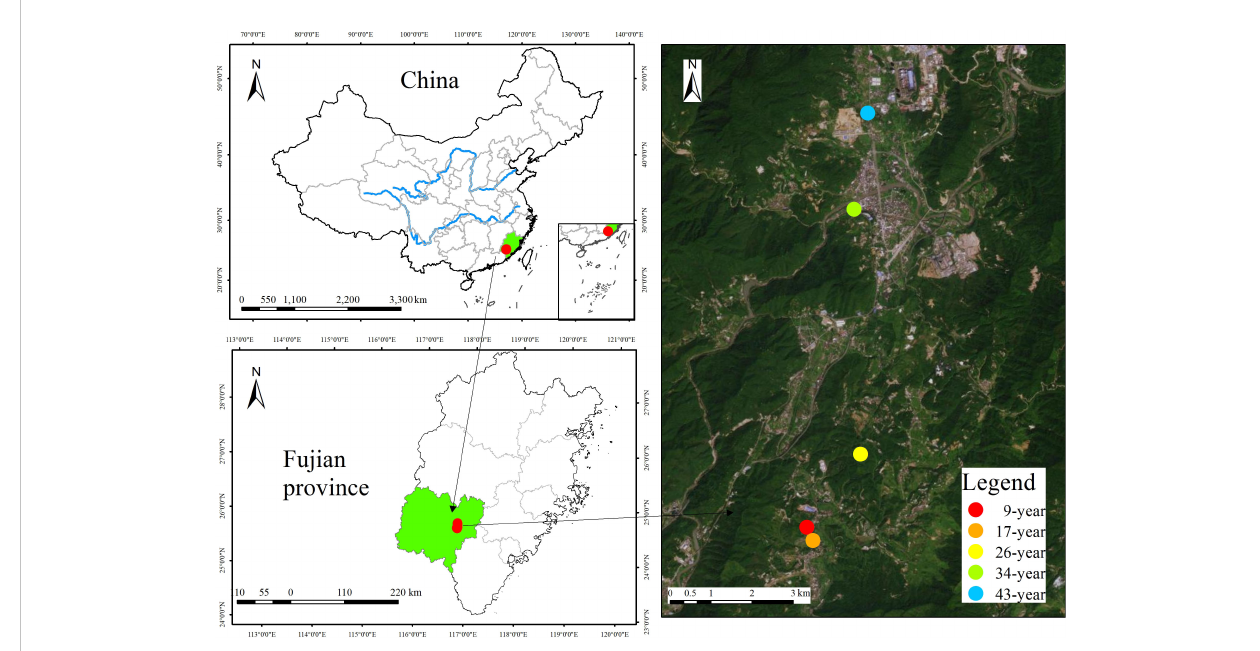
FIGURE 1 Location of different-aged Pinus massoniana plantations in Longyan city, Fujian province,